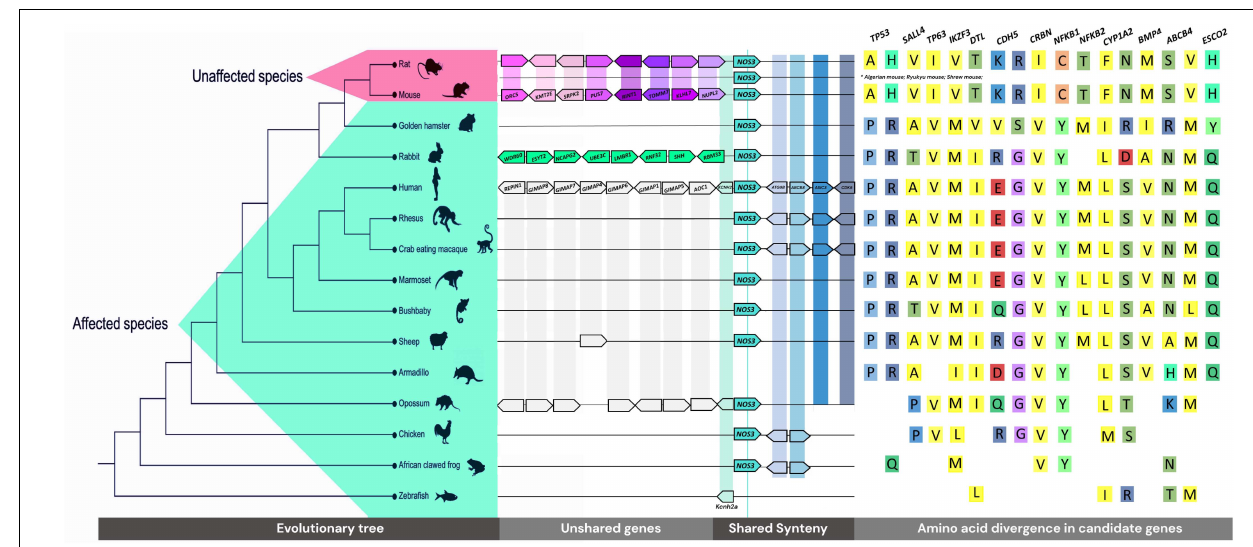
FIGURE 2 | Genomic tree of the evaluated species, synteny and neighborhood of NOS3 gene, and the main variants encountered in mice and rats, which are reported in gnomAD